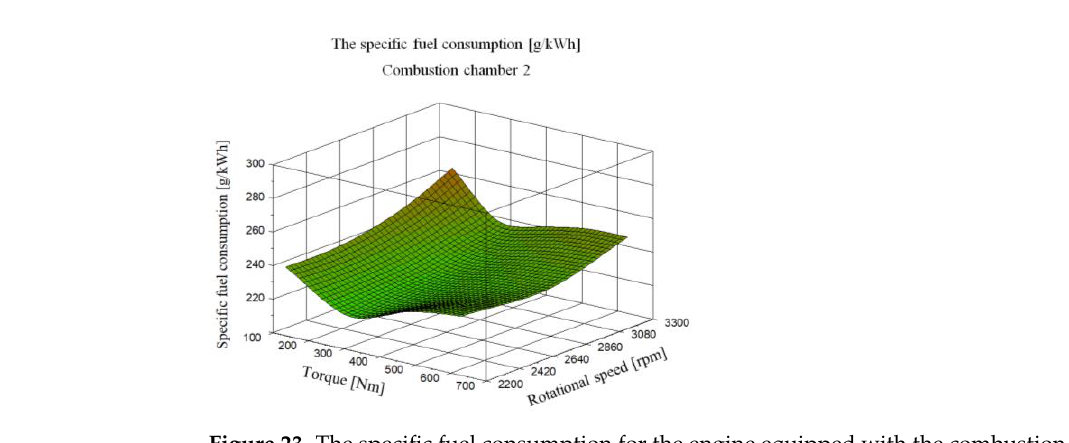
Figure 23. The specific fuel consumption for the engine equipped with the combustion chamber 2.